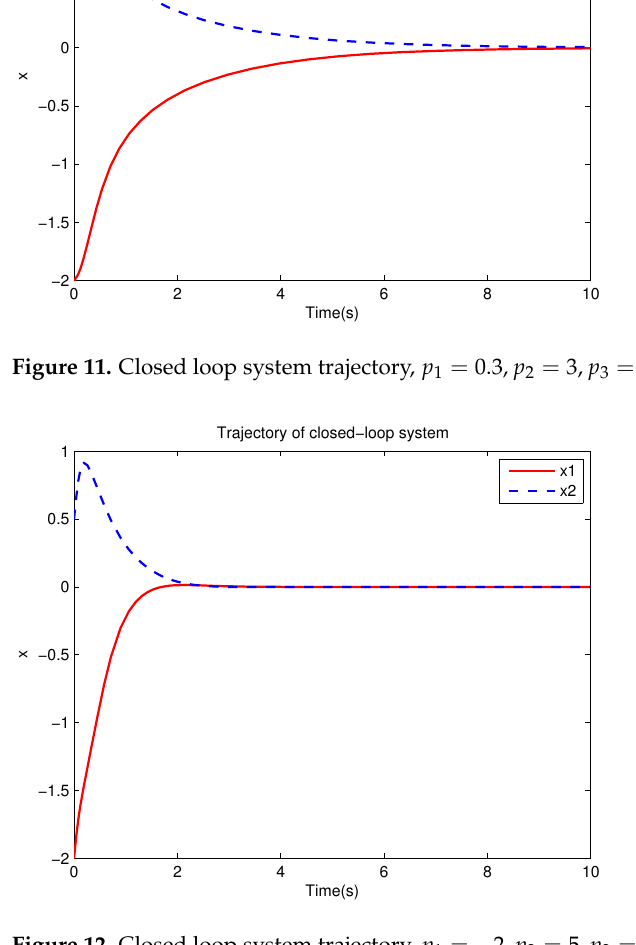
Figure 12. Closed loop system trajectory, p 1 = − 2, p 2 = 5, p 3 =